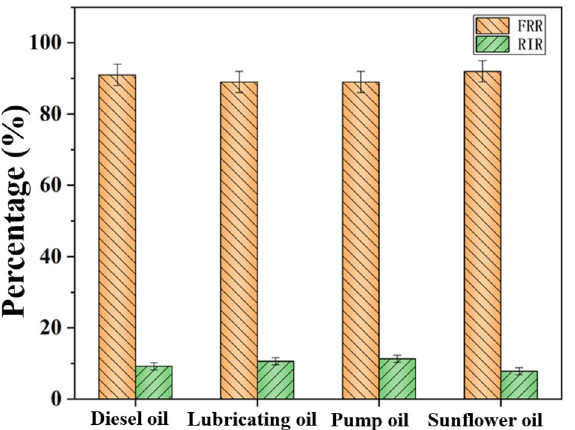
Figure 18. Flux recovery ratio (FRR), and irreversible fouling ratio (RIR) of OTS-PDA-MS for oil absorption with various oil.